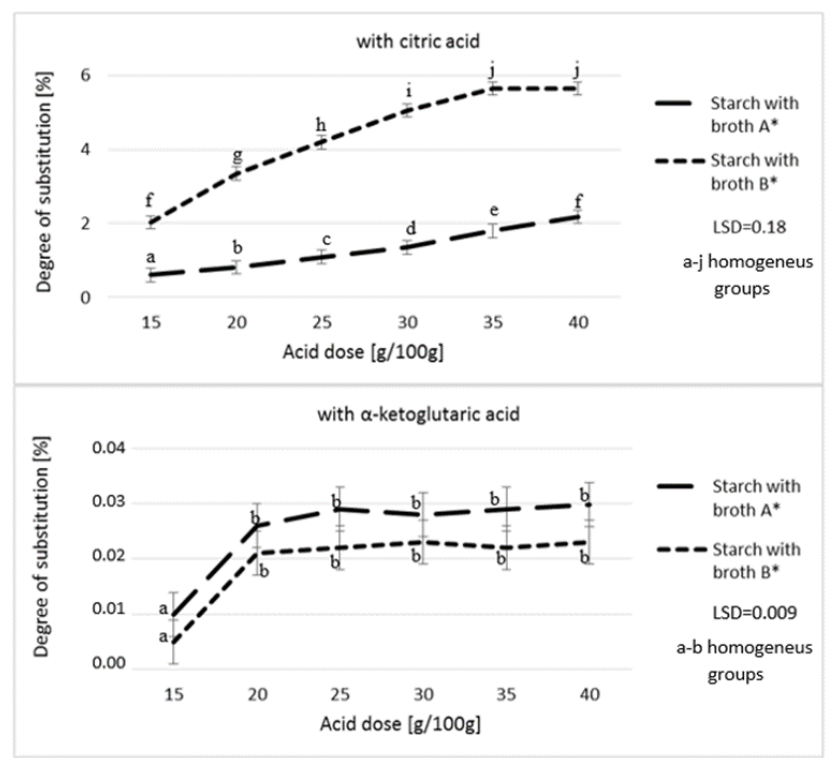
Figure 1. Effect of acid dose on the degree of starch substitution. * Broth A— α -ketoglutaric acid 60 g/L; citric acid 18 g/L; pyruvic acid 1 g/L; Broth B— α -ketoglutaric acid 49 g/L; citric acid 46 g/L; pyruvic acid 1.5 g/L.